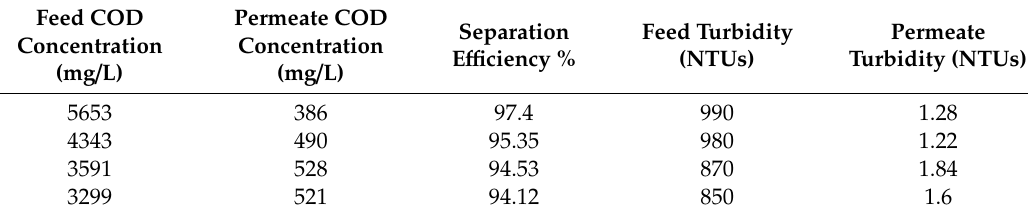
Table 3. E ff ect of oil concentration on the properties of treated water.